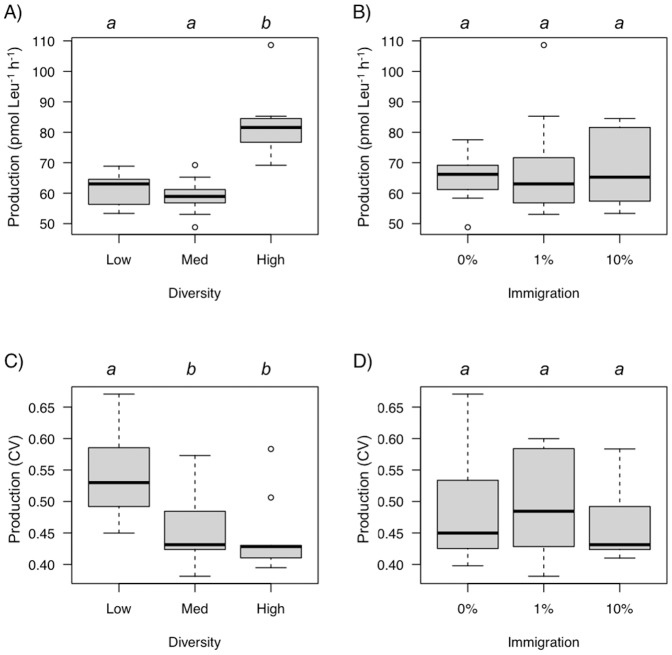
The effect of diversity (A) and immigration (B) on global temporal mean bacterial production during the experiment (from 48 h to 240 h of incubation) and the effect of diversity (C) and immigration (D) on the temporal coefficient of variation (CV) for production.Diversity or immigration levels connected by the same letter are not significantly different (Tukey-Kramer test, p<0.05).